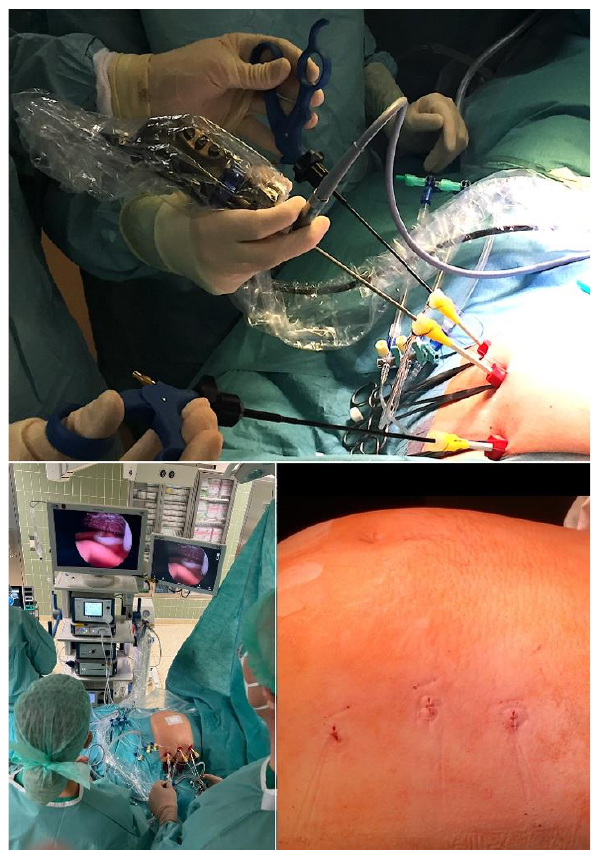
Figure 8. External aspect of the fully percutaneous setup for minimally invasive fetoscopic surgery for fetal spina bifida aperta. Top — after percutaneous intraamniotic insertion of three 11F-sheaths, followed by partial amniotic carbon dioxide insufflation (PACI), and fetal posturing ( bottom left ), surgery on the malformation (Figure 9) can commence. Bottom right — the maternal abdomen after trocar removal illustrates the minimal maternal trauma of the approach.